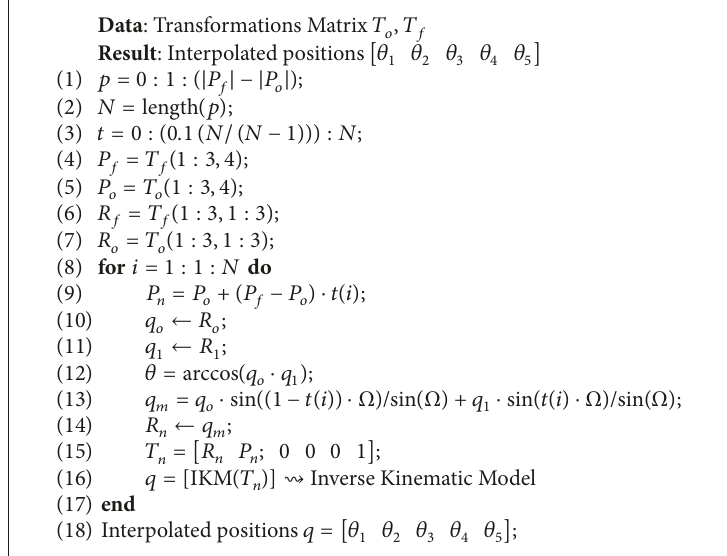
Algorithm 2: Algorithm for joint movement of MOVES.